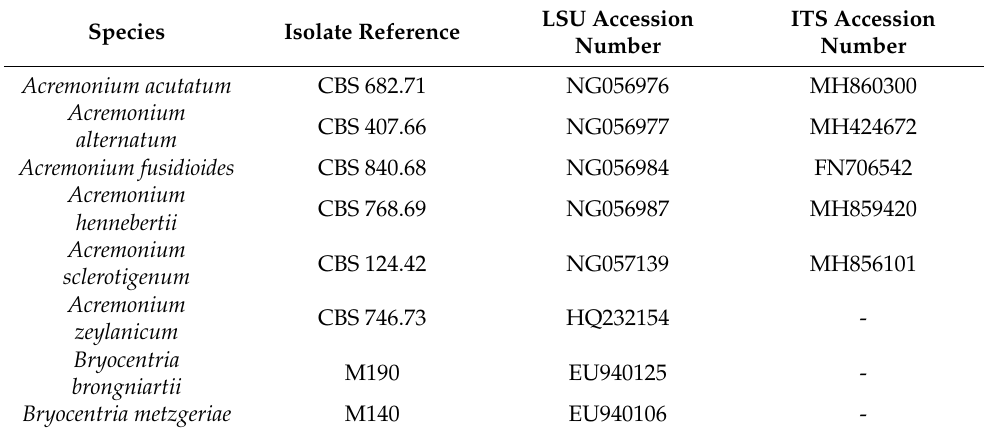
Table 1. List of reference isolates considered in the phylogenetic analyses and their respective GenBank accession numbers. The newly generated sequences are presented in black and bold